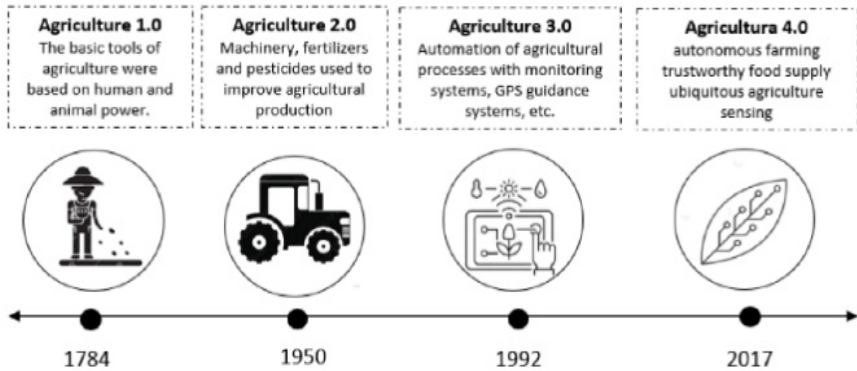
Figure 1. The evolutionary phases of agriculture [2].